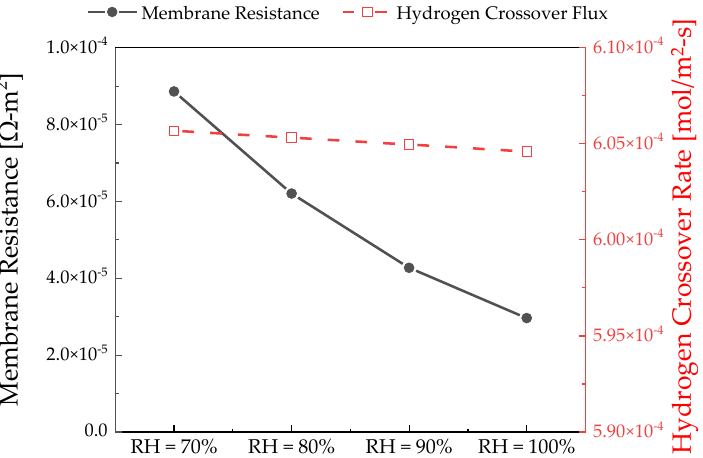
Figure 14. Polymer electrolyte membrane resistance and hydrogen crossover flux according to the thickness measured at 0.18 V.